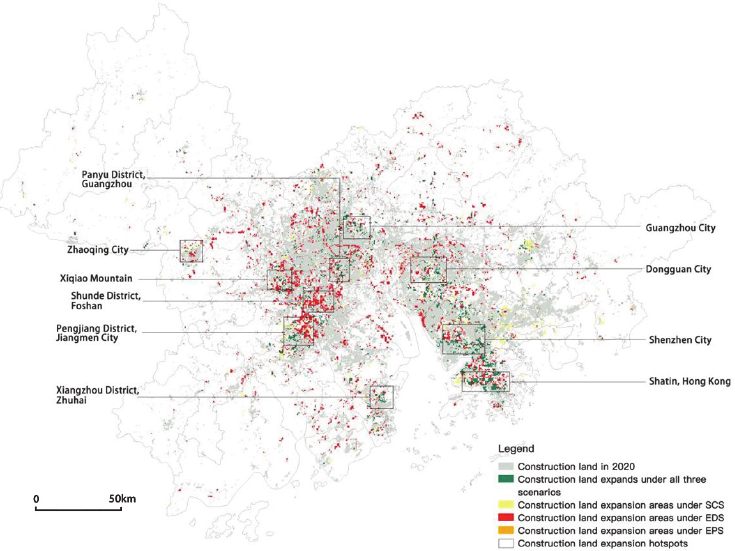
Figure 12. Hotspots of built-up land expansion.